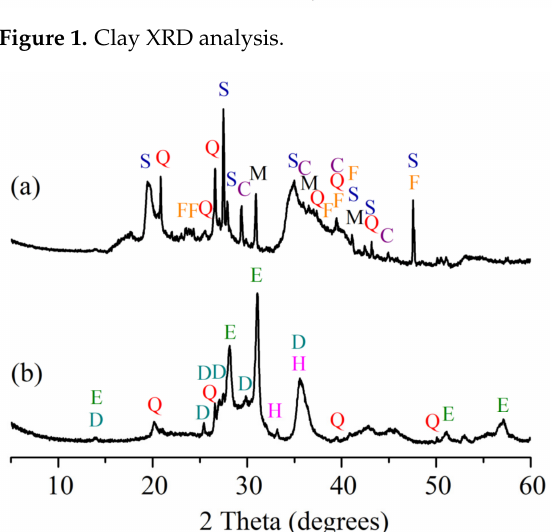
Figure 2. OCW analysis: ( a ) before firing; ( b ) fired at 1000 ◦ C.